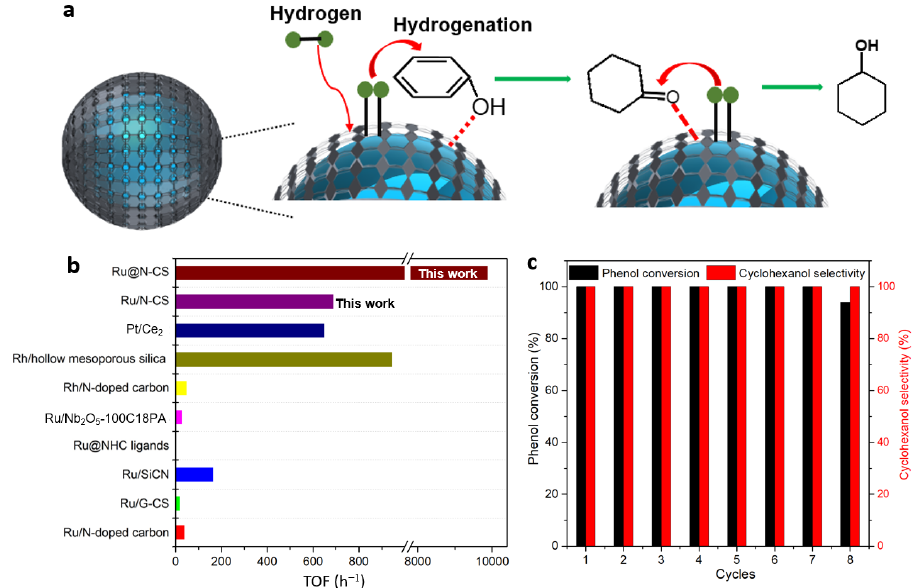
Figure 3. Study on the catalytic performance of phenol hydrogenation into cyclohexanol over Ru@N-CS catalyst. ( a ), Proposed reaction mechanism for hydrogenation of phenol into cyclohexanol. ( b ), Comparison of TOF values for Ru@N-CS catalyst and other Ru-based catalysts. ( c ), Recyclability tests of phenol conversion over Ru@N-CS catalyst under the conditions: 0.1 g phenol, 10 mL water, mass ratios of phenol to Ru 13,000:1, 80 °C, 0.5 MPa H 2 , 30 min.